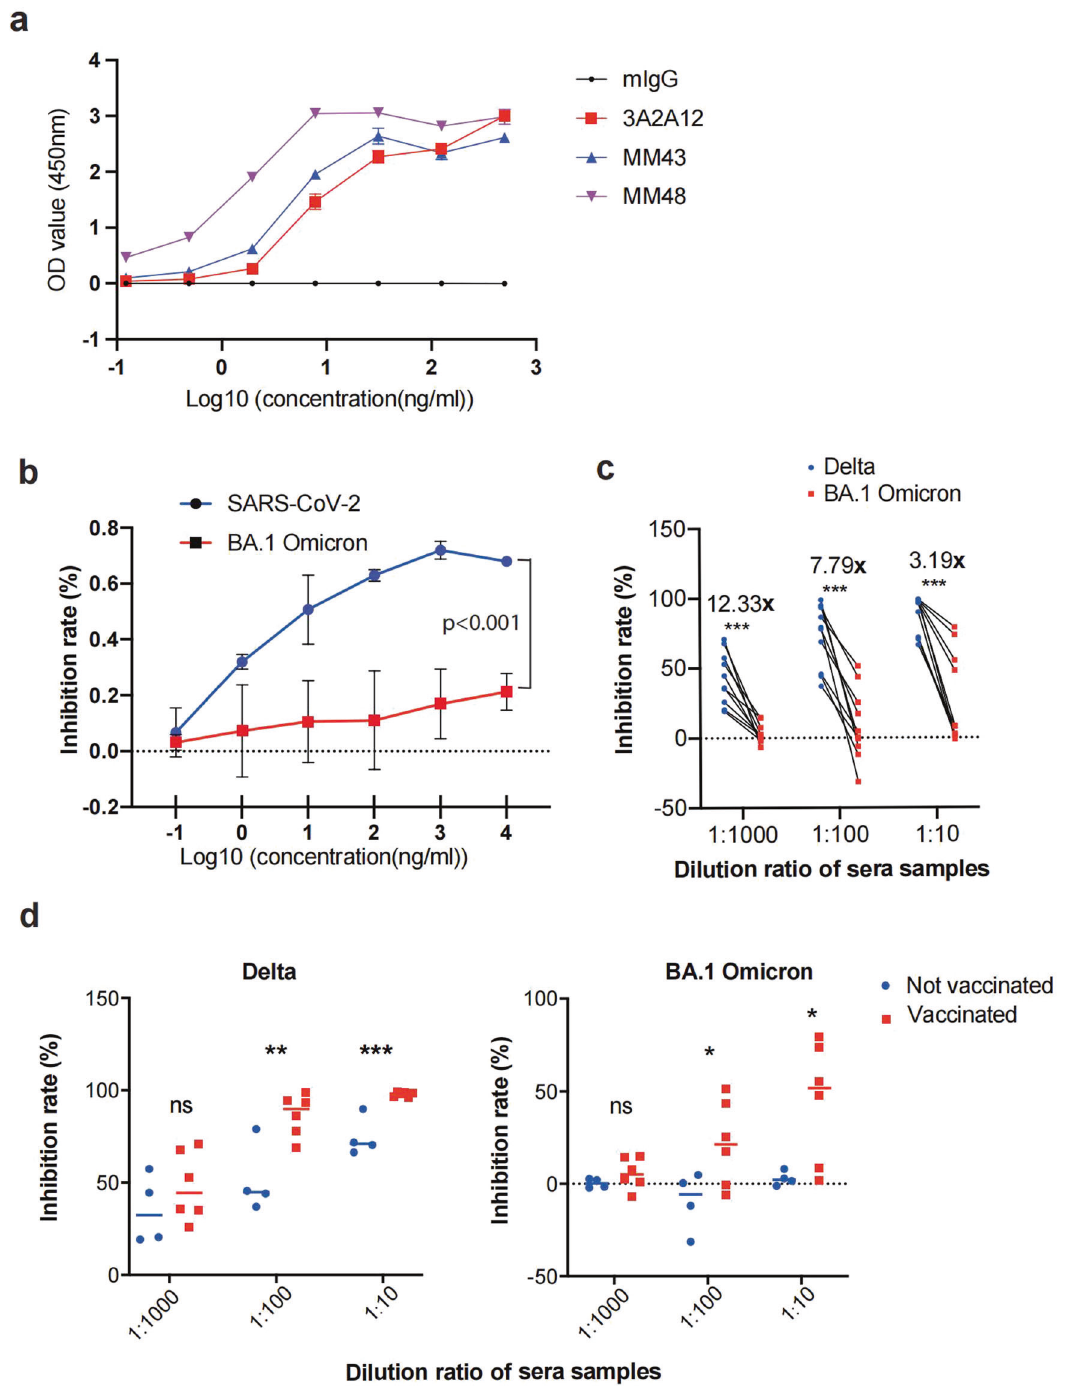
Fig. 1 Immune escape by the BA.1 Omicron variant. a The ELISA assay shows the binding ability of 3A2A12, MM43, MM48 and mouse IgG to SARS-CoV-2 RBD ( n = 4). b The neutralizing ability of 3A2A12 for SARS-CoV-2 and BA.1 Omicron pseudoviruses ( n = 3), p < 0.001, determined by two-way ANOVA. c Inhibition of Delta and BA.1 Omicron pseudoviruses by convalescent patient sera ( n = 10). d Inhibition of Delta (left) and BA.1 Omicron (right) pseudoviruses by COVID-19 convalescent patient sera in vaccinees ( n = 6) and non-vaccinated group ( n = 4). Data are represented as mean ± SEM, p -value was determined by the Wilcoxon rank sum test, (* p < 0.05, ** p < 0.01, *** p <